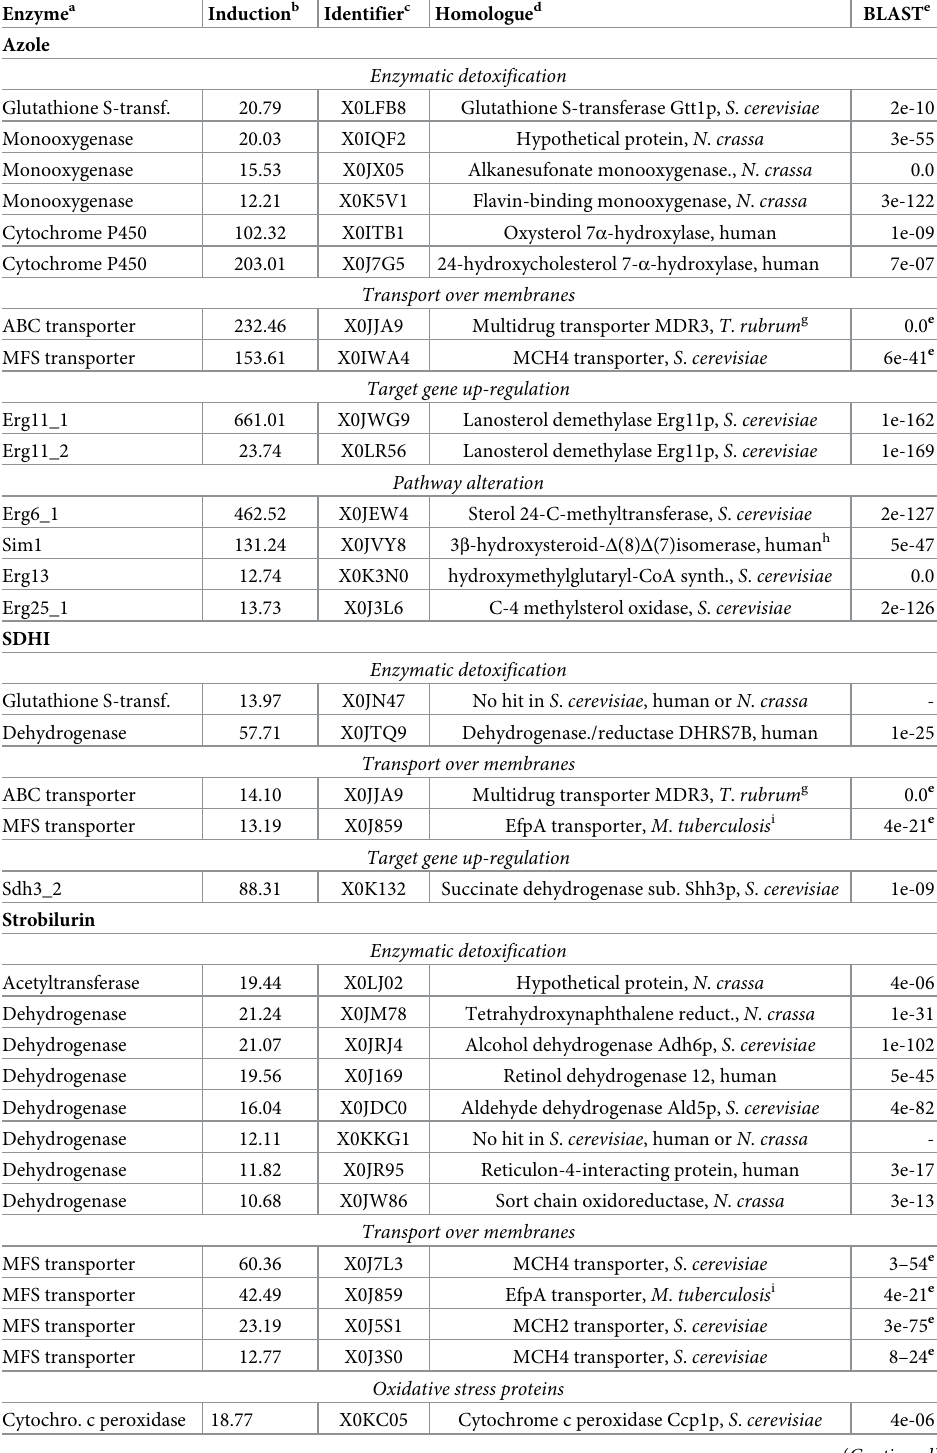
Table 2. Strongly induced genes, putatively involved in fungicide tolerance in